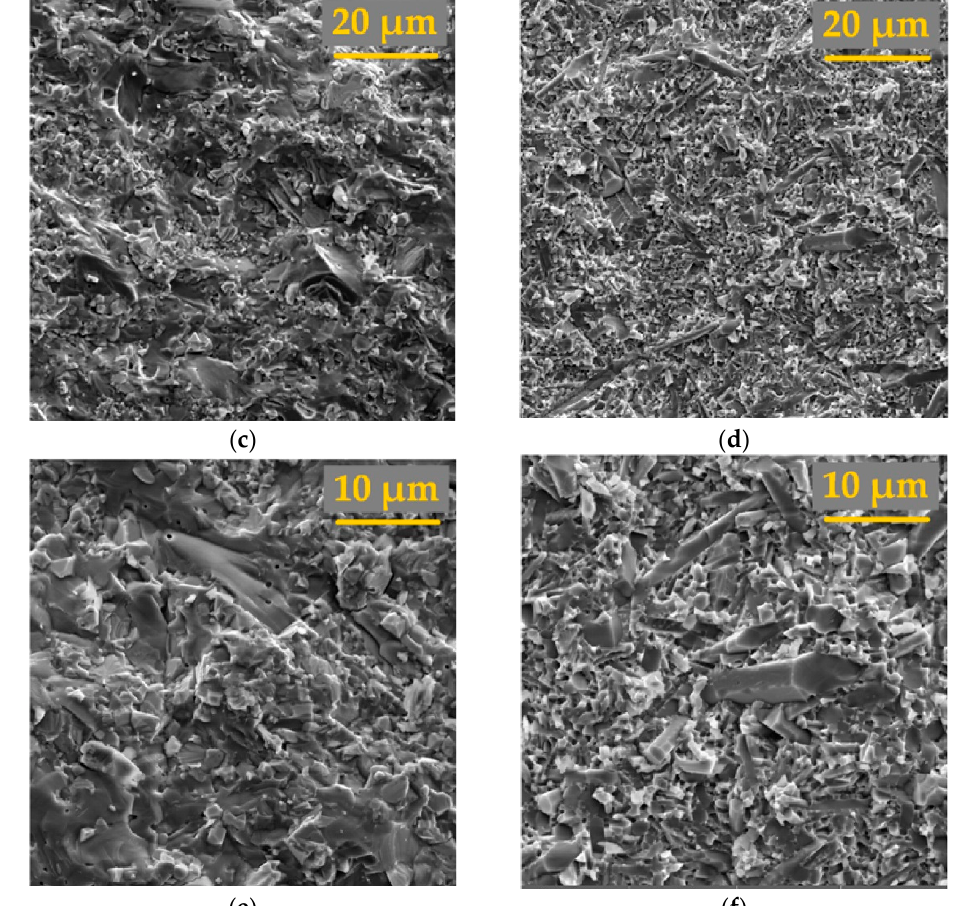
Figure 10. SEM images of fracture surface microstructures of sintered ceramic samples based on SiAlON: ( a ) experimental sample 80% (90 α 10 β ) + 20% TiN, ×1000; ( b ) specimen of commercial ceramics, ×1000; ( c ) experimental sample 80% (90 α 10 β ) + 20% TiN, ×5000; ( d ) specimen of commercial ceramics, ×5000; ( e ) experimental sample 80% (90 α 10 β ) + 20% TiN, ×10,000; and ( f ) specimen of commercial ceramics, ×10,000.